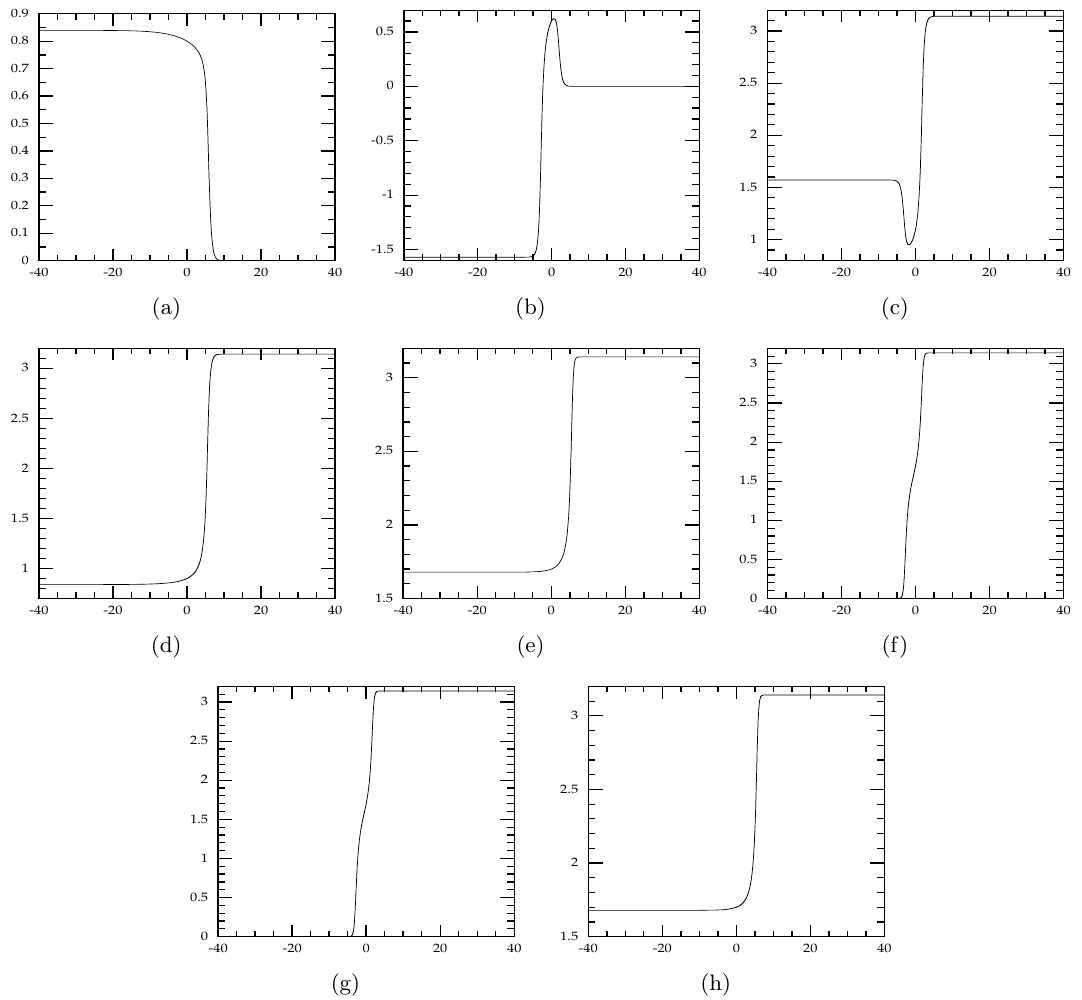
Figure 15 . SO(5) (cid:12)elds | case III; (a), (b), (c), (d) (cid:12)eld ’ 1 and (e), (f), (g), (h) (cid:12)eld ’ 2 . Solutions correspond to simulations started with the initial data ’ 2 (0) = 1 : 7 and di(cid:11)er by the choice of ’ 1 (0). The cases with ’ 1 (0) = 0 : 8 are shown in plots (a), (e), those with ’ 1 (0) = 0 : 6 in (b), (f), ’ 1 (0) = 1 : 1 in (c), (g) and those with ’ 1 (0) = 0 : 9 in plots (d) and (h).